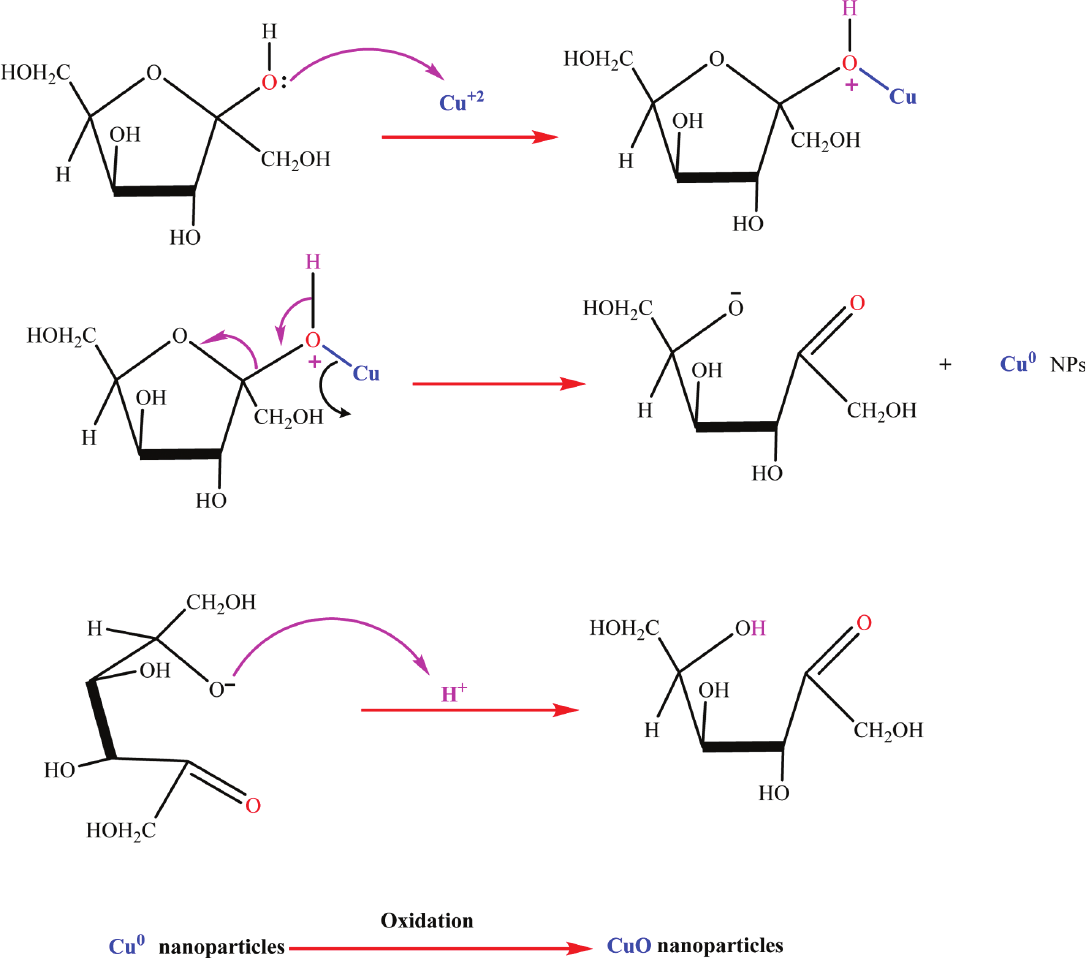
Scheme 3: Schematic illustration of synthetic steps for bioreduction of copper cations using aqueous wheat extract (wheat-derived fructose as bioreducing agent